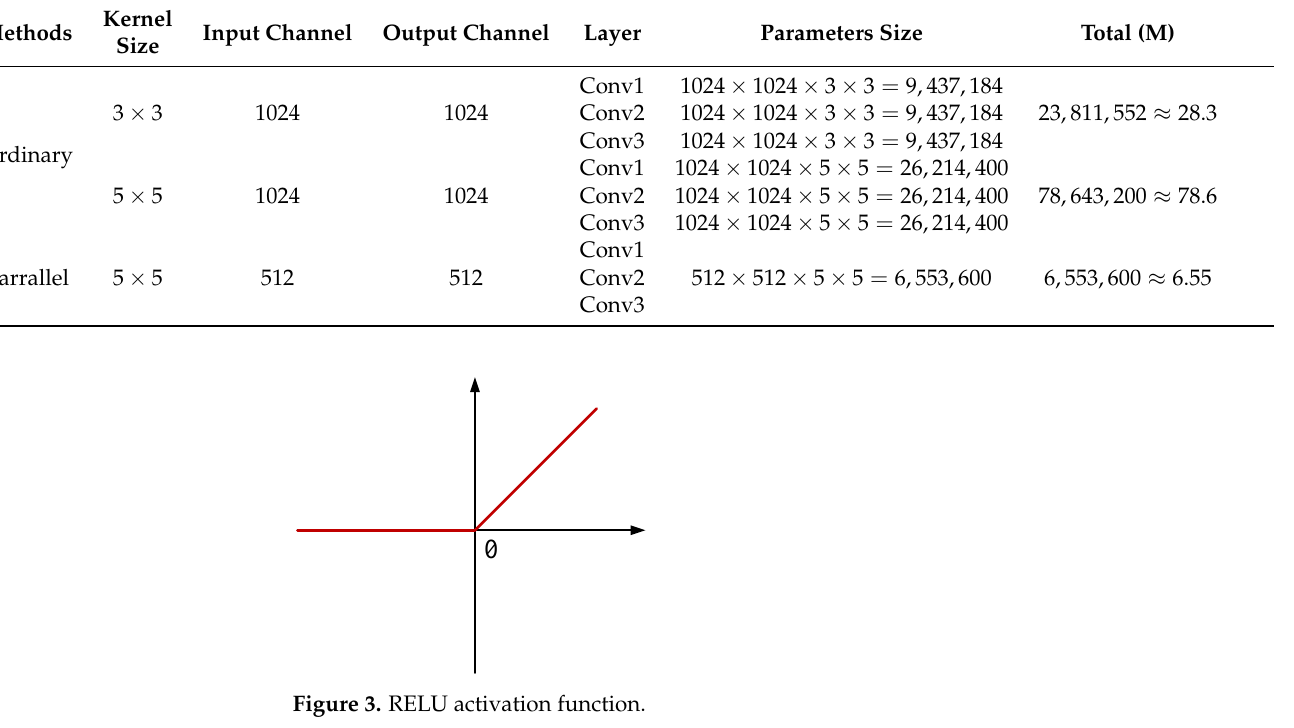
Table 1. Comparison between different convolutions.